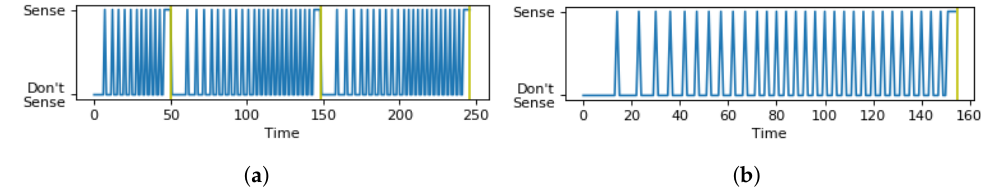
Figure 15. Sensing schedules using the same sensor group to detect the same state, ( a ) using the binning technique or ( b ) using the VCAMS [14] method for modeling the behavior of the